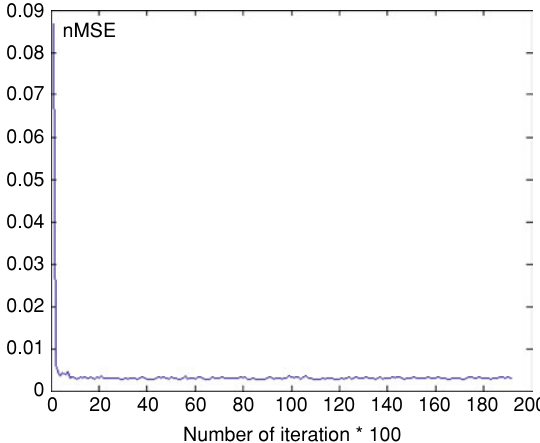
Figure 15 Via point determination learning curves.